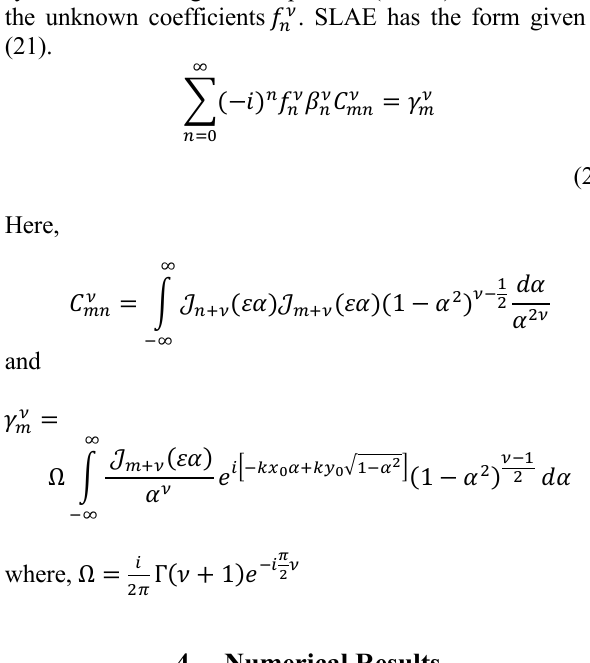
= 2𝜋 and 𝑦 = 2𝜋 F F